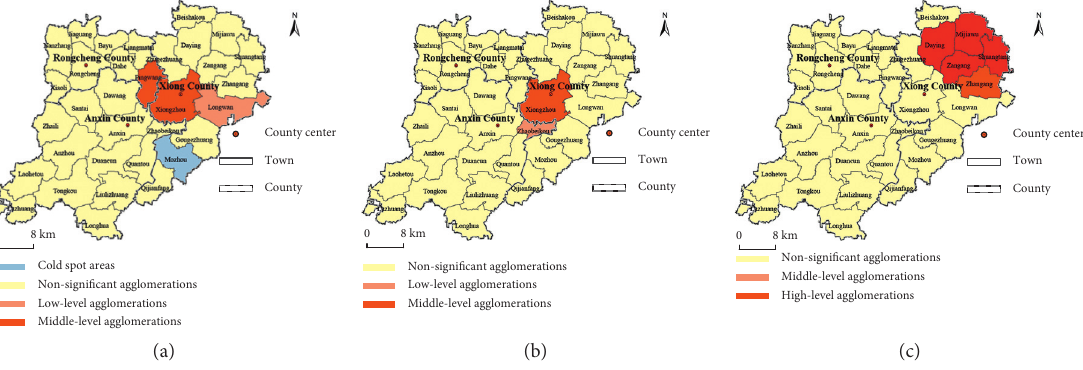
Figure 5: Hot spot distribution of enterprises chain e-commerce enterprises in Xiong’an New Area. (a) B2B enterprises hot spots. (b) B2C enterprises hot spots. (c) B2G enterprises hot